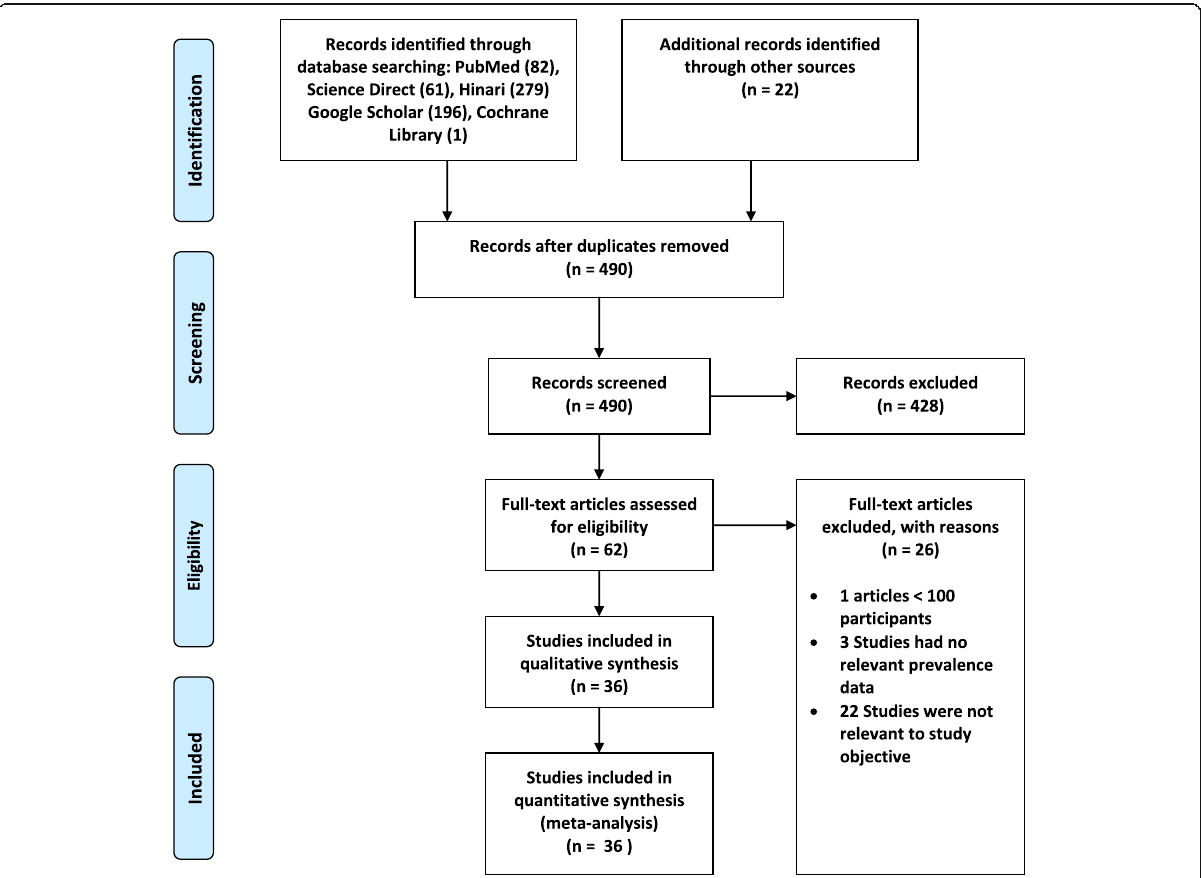
Fig. 1 Flow diagram, systematic review, blood and body fluid exposure among healthcare workers in Ethiopia, 2007 –